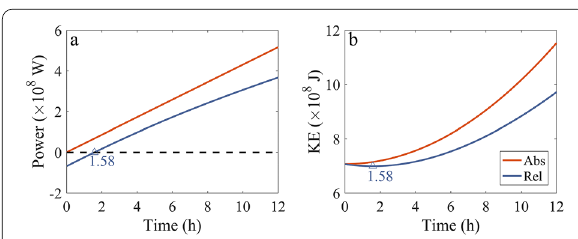
Fig. 3 Time series of power ( a ) and kinetic energy ( b ) area integration. The blue line and red line indicate relative and absolute, respectively